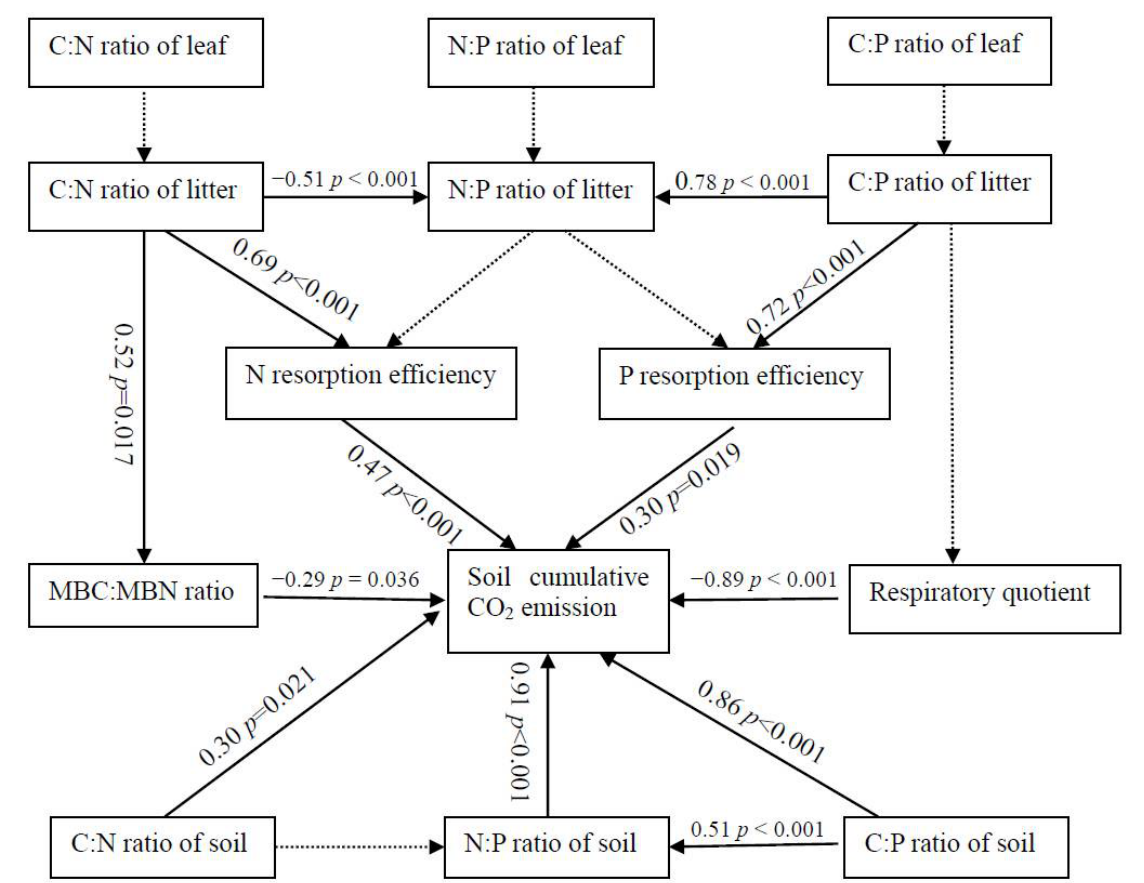
Figure 9. Structural equation model of the effects of above- and belowground stoichiometry on soil annual cumulative CO 2 emissions.